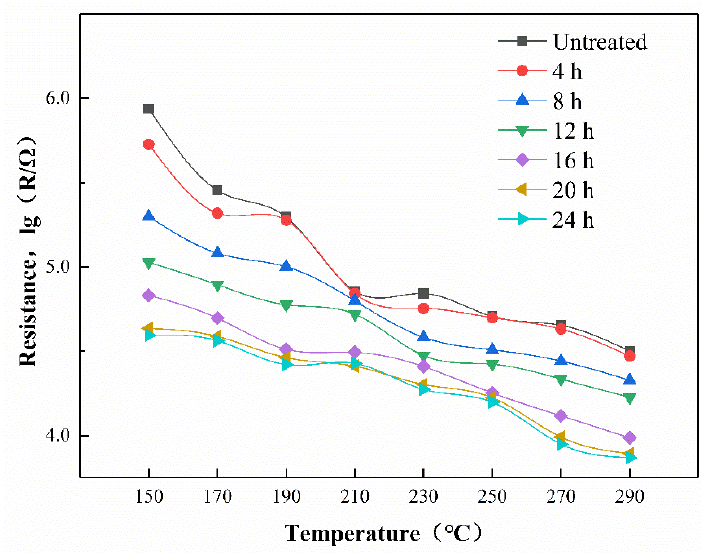
Figure 13. The temperature-resistance curve of gas